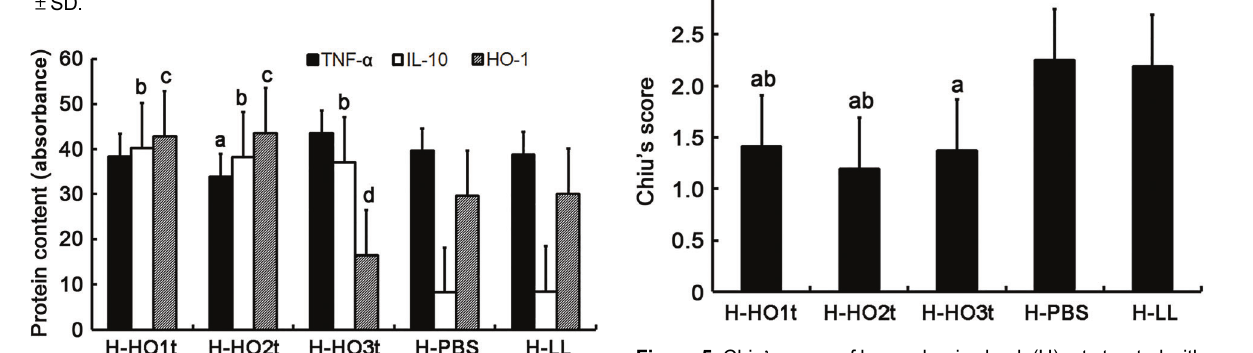
Figure 5. Chiu ’ s score of hemorrhagic shock (H) rats treated with Lactococcus lactis expressing heme oxygenase-1 once (HO1t), twice (HO2t) or thrice (HO3t) or with phosphate-buffered saline (PBS) and L. lactis (LL). a P o 0.05: compared with PBS and LL; b P o 0.05: compared with HO1t and H-HO3t (ANOVA). Data are reported as means ±